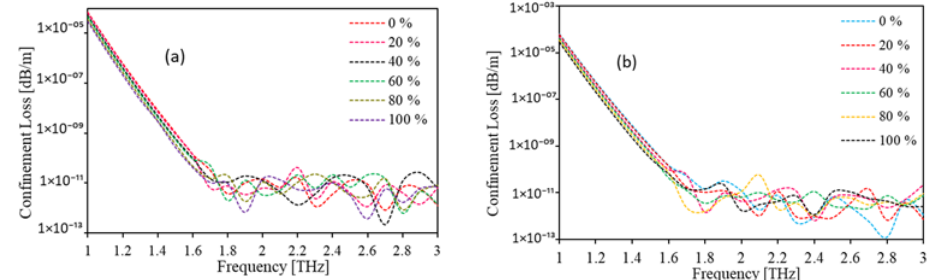
Figure 10. The CL for ( a ) hexagonal, ( b ) circular core with the change of frequency for D = 643.34 μ m, D c = 280 μ m, t = 15 μ m, z = 10 μ m.